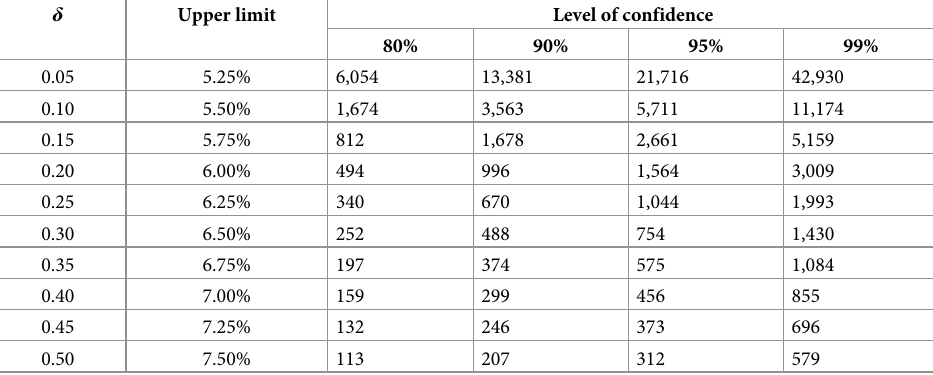
Table 4. Sample size required in order to obtain an expected upper limit of a one-sided exact confidence interval estimate equal to the given values, for a range of confidence levels, assuming the true probability of an adverse outcome = 0.05 (i.e.,